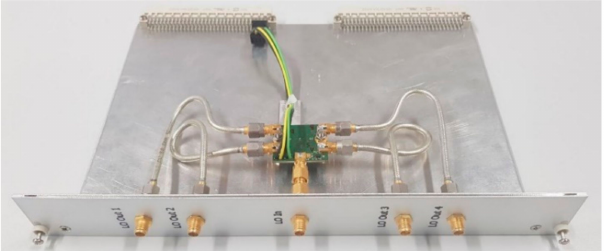
Figure 14. Photos of the LO distribution module showing the four-way PCB LO splitter connected to the front panel SMAs through coaxial cables.